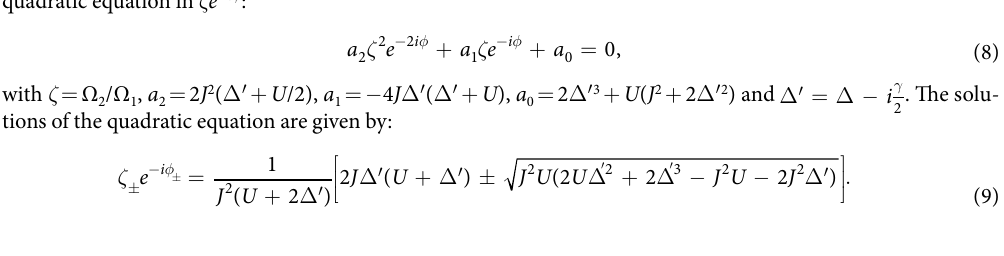
(2) as a function of Δ / γ with U = U opt for different values of J . ( b ) b (2) and ( c ) temperature dependence of g (0) (2) . b b (2) b